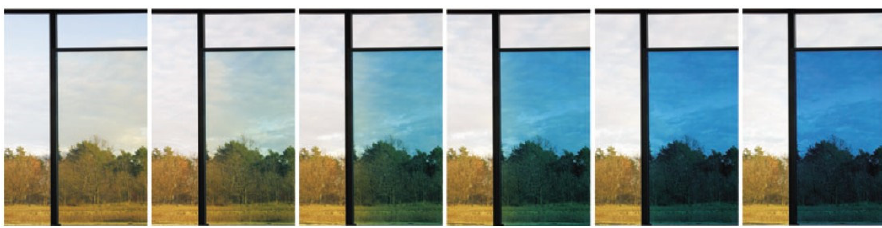
Figure 20. ECW color cycle (colored ↔ semitransparent ↔ transparent